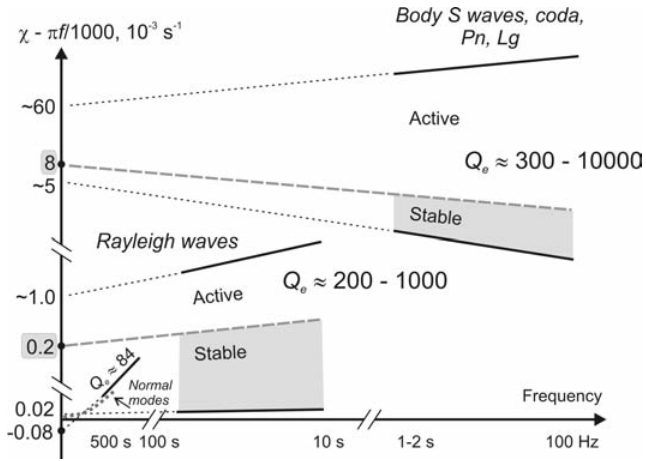
Figure 1. Summary of the observed | ( f ) dependences for Rayleigh waves and short-period body, Lg, Pn, and coda waves. «Reduced» values of ( | – r (cid:0) f /1000) are shown, so that the linear dependences corresponding = 1000 appear horizontal. Typical ranges of Q e , and (cid:0) c levels that to Q e discriminate between the stable and active tectonic regimes are indicated by lines and gray boxes, respectively. Modified from M10b, with permission from